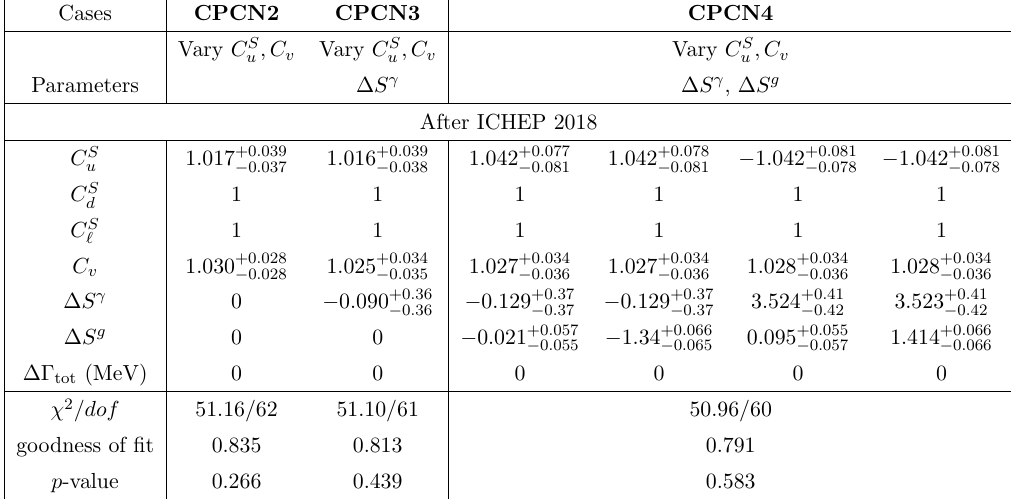
Table 6 . CPCN : the best-(cid:12)tted values in various CP conserving (cid:12)ts and the corresponding chi- square per degree of freedom and goodness of (cid:12)t. The p -value for each (cid:12)t hypothesis against the SM null hypothesis is also shown. For the SM, we obtain (cid:31) 2 = 53 : 81, (cid:31) 2 =dof = 53 : 81 = 64, and so the goodness of (cid:12)t = 0 : 814.